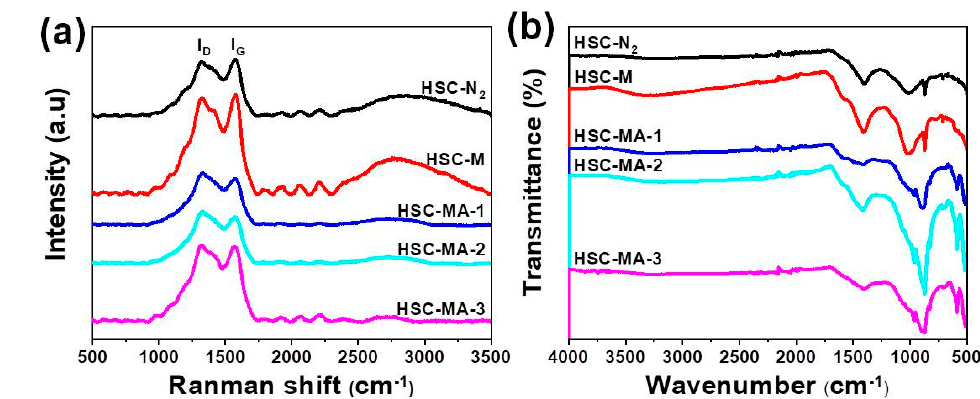
Figure 4. Raman ( a ) and FTIR ( b ) spectra of HSC-N 2 , HSC-M, HSC-MA-1, HSC-MA-2, and HSC-MA-3.